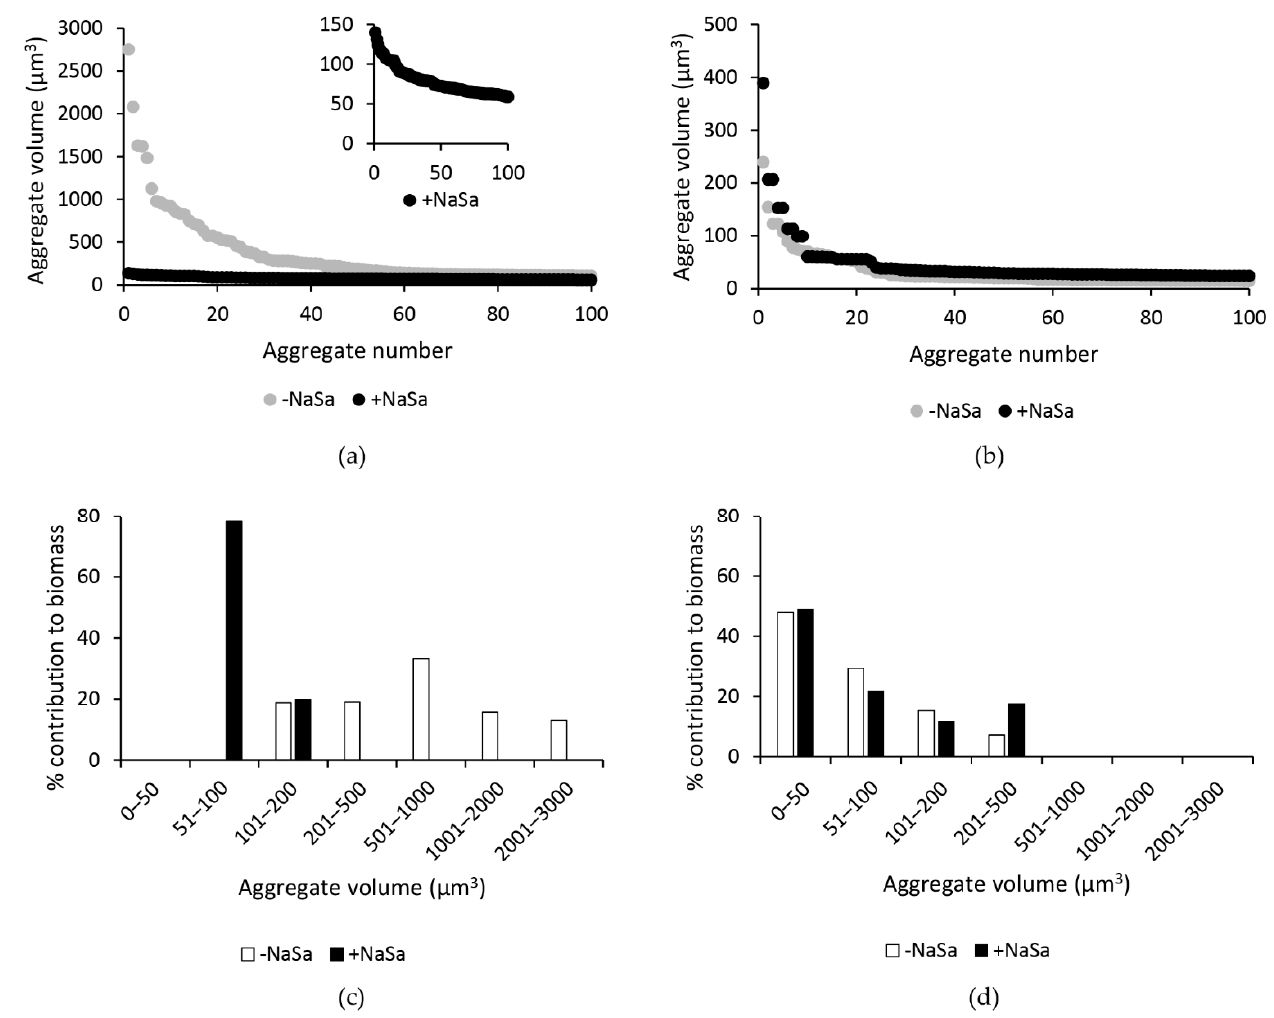
Figure 4. Sodium salicylate (NaSa) reduces the formation of large aggregates of PAO1 wt-GFP but not PAO1 ∆ lasR ∆ rhlR -GFP. Aggregate volumes of the 100 largest aggregates (selected from a dataset based on the 10 largest aggregates per z-stack), in the presence or absence of 10 mM NaSa, of ( a ) PAO1 wt-GFP and ( b ) PAO1 ∆ lasR ∆ rhlR -GFP. The aggregate size distribution in cultures with NaSa was narrower than that observed in cultures without NaSa of ( c ) PAO1 wt-GFP but not of ( d ) PAO1 ∆ lasR ∆ rhlR -GFP.